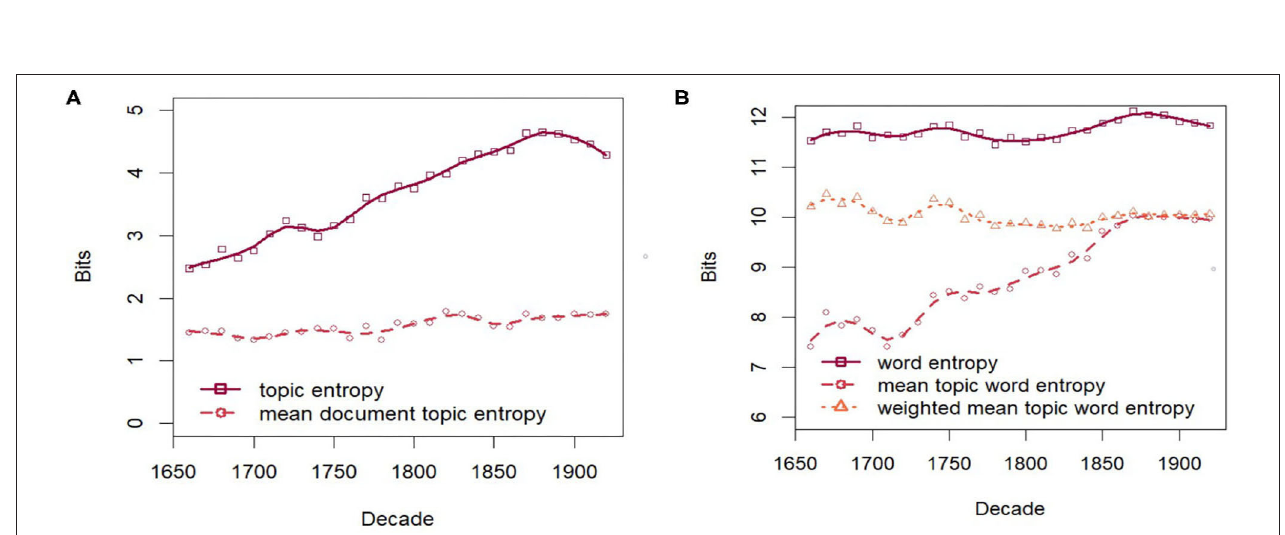
FIGURE 6 | Entropies over time. (A) Entropy of topics. (B) Entropy of words.